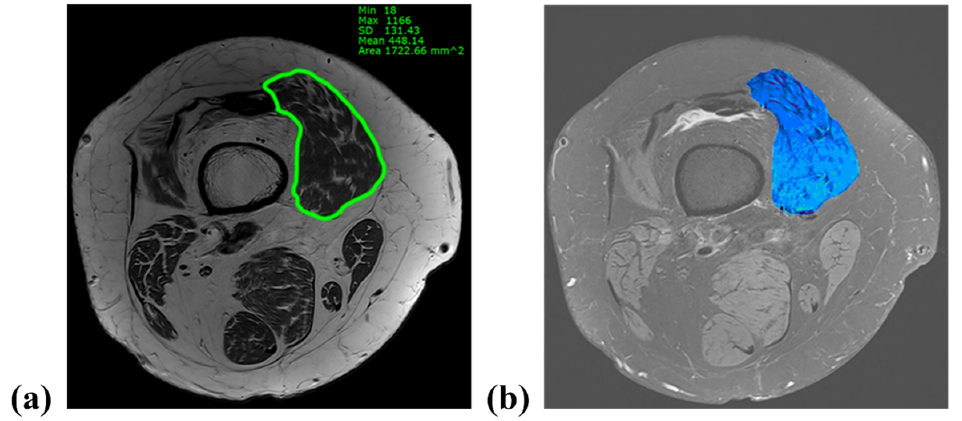
Figure 3. Measurement of cross-sectional area (CSA) and fat infiltration (FI) ratio on axial magnetic resonance imaging. ( a ) The vastus medialis (VM) CSA was acquired from the axial proton density image after marking the VM margin using the embedded tools of the picture archiving communication system software. ( b ) The area corresponding to the VM was color-mapped with 16 different colors for each signal. Color pixels derived from the fat signal were extracted, and the FI ratio was defined as the percentage of the number of fat pixels to the sum of the VM pixels.